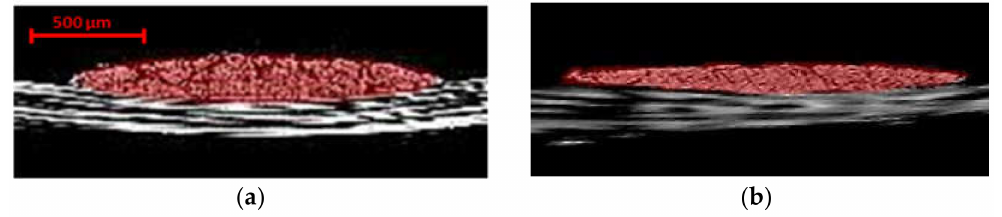
Figure 12. ( a ) A good estimation of a yarn section by ellipse shape; ( b ) a yarn section that cannot be estimated by ellipse shape.